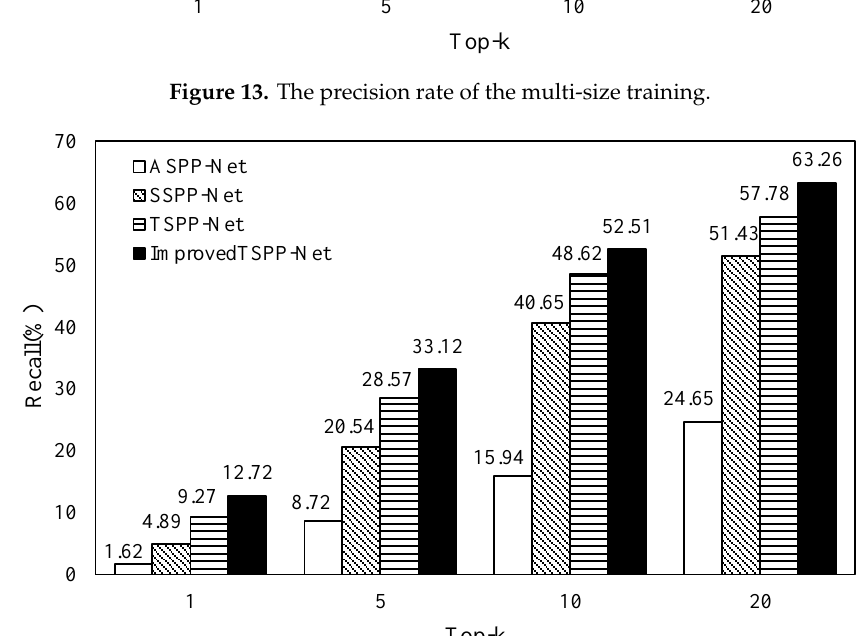
Figure 14. The recall rate of the multi-size training.